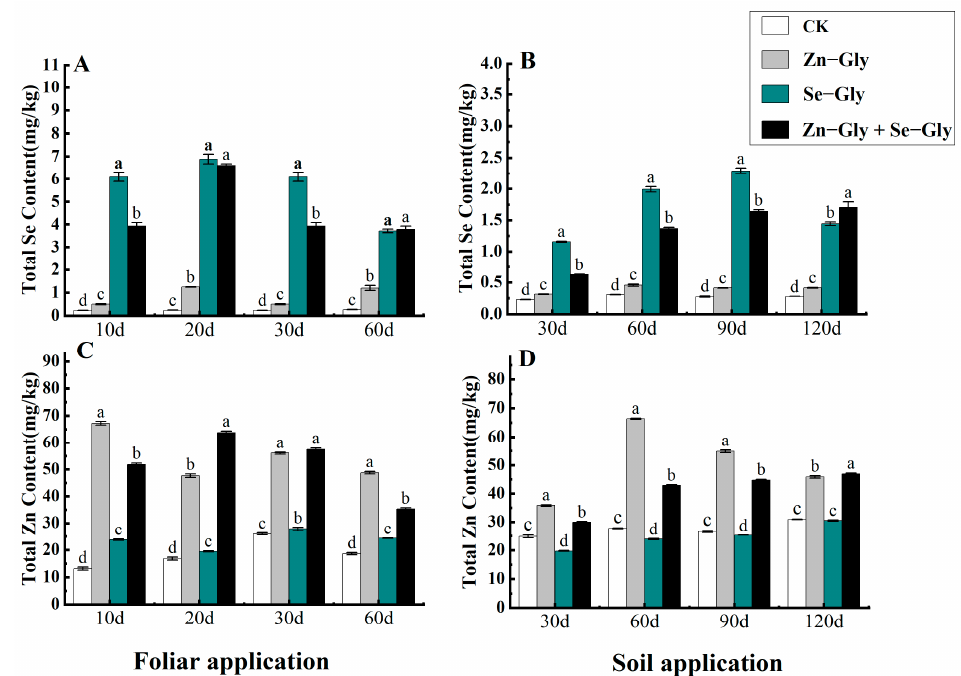
Figure 3. The content of zinc and selenium in tea leaves under different fertilization treatments. ( A , C ) Content of zinc and selenium in tea leaves following foliar fertilizer application; ( B , D ) Content of zinc and selenium in tea leaves following soil fertilizer application. The abscissa shows the days of treatment. Different colors represent different treatments, from left to right: CK, Zn − Gly, Se − Gly, Zn − Gly +Se − Gly. Results labeled with the same letters on the histogram are not significantly different at p < 0.05.